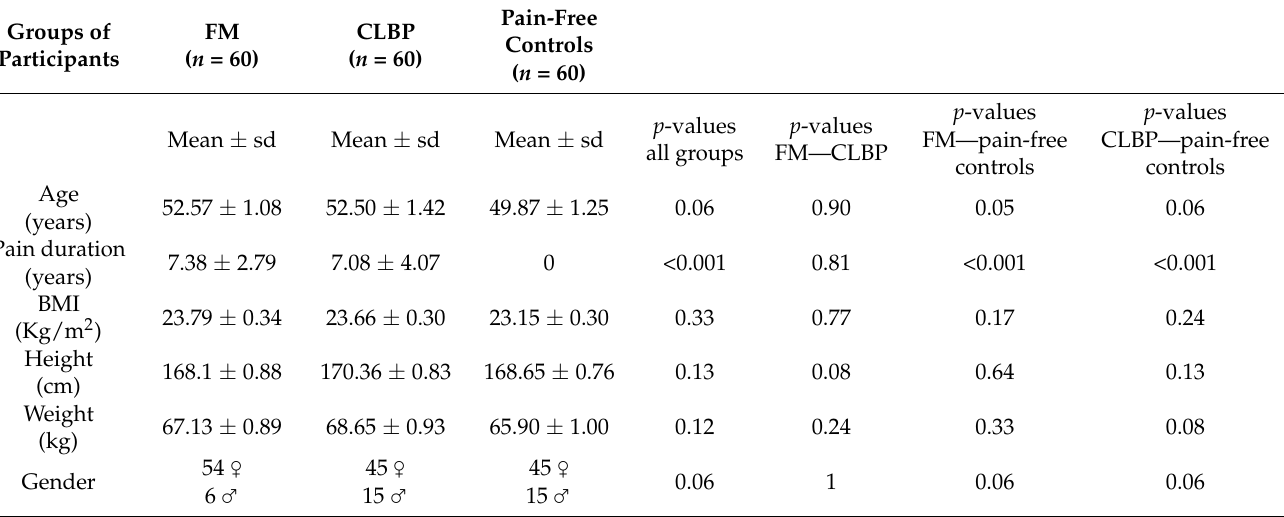
Table 1. Sociodemographic data from the three groups of participants.